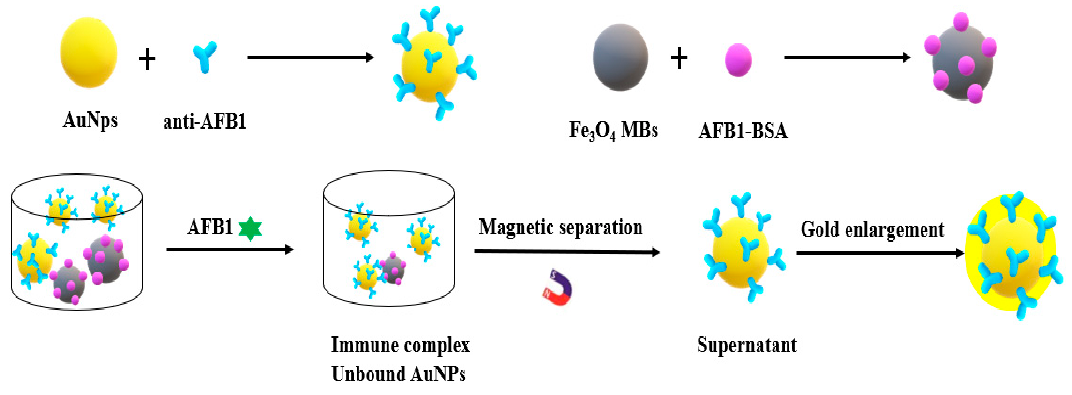
Figure 4. Schematic illustration of the homogeneous gold staining for amplified optical detection of